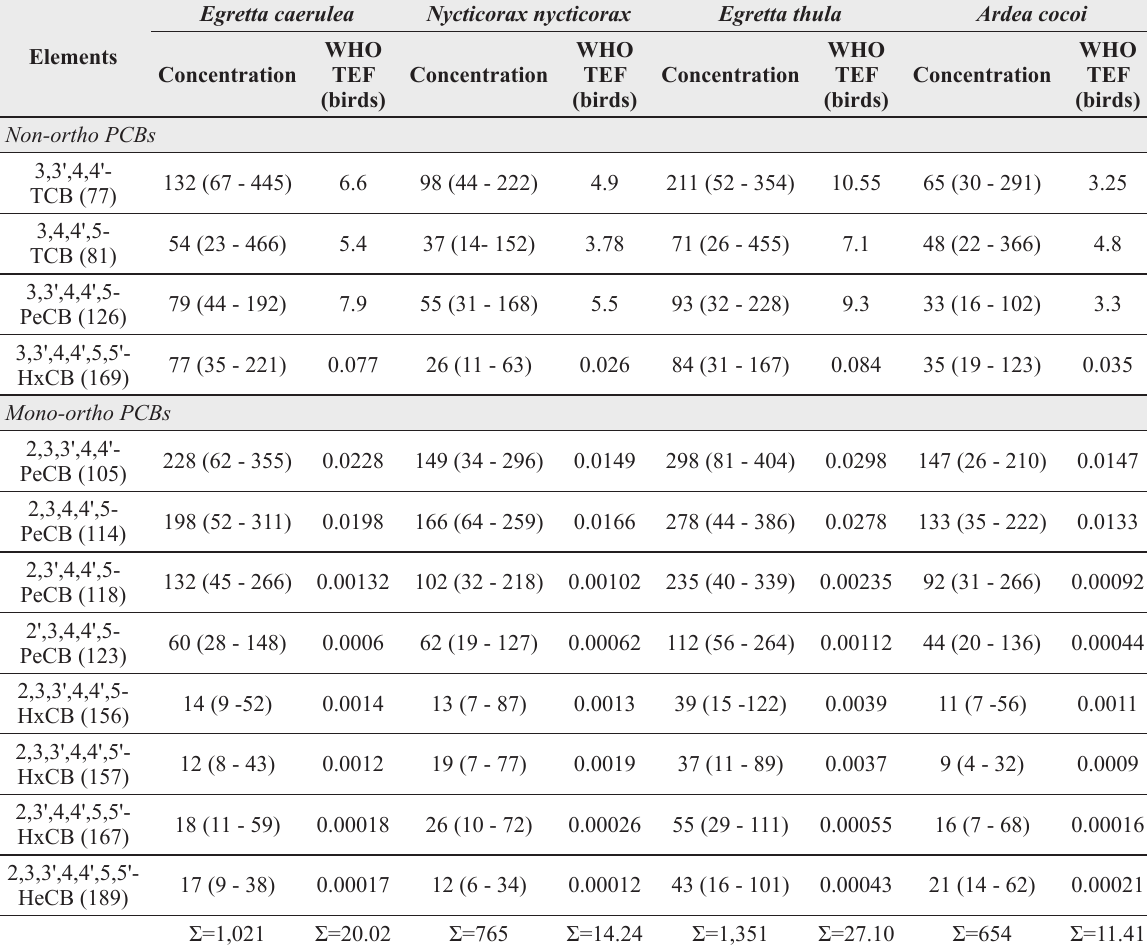
Medians (range) of concentrations as pg/g lipid weight of PCBs and toxic equivalents of